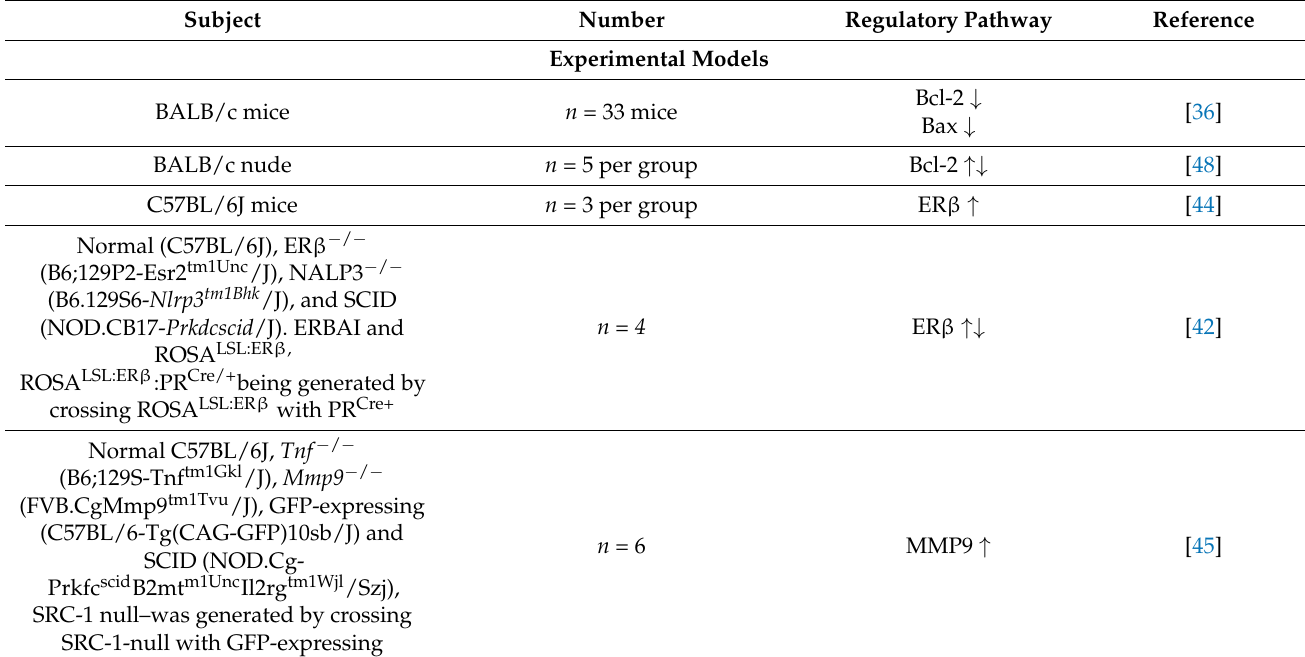
Table 2. Summary content regarding the outcomes in which we investigated the apoptotic and potential